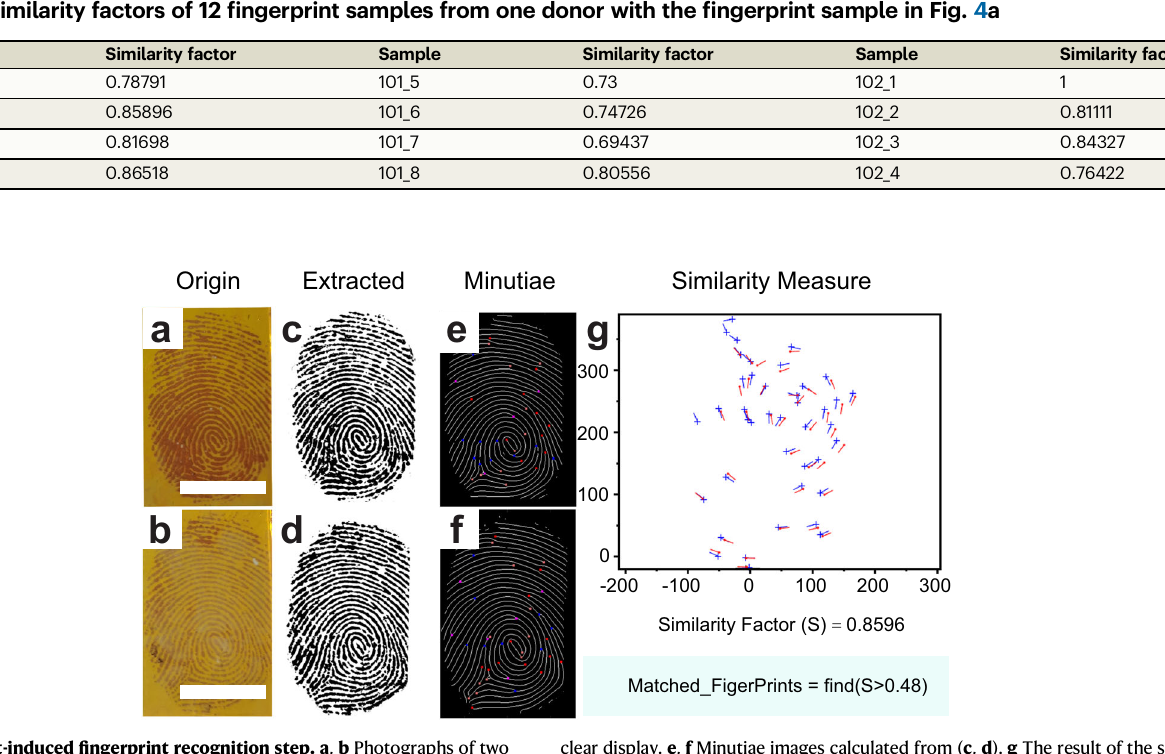
Fig. 4 | Sweat-induced fi ngerprint recognition step. a , b Photographs of two sweat-induced fi ngerprints. c , d Images extracted from ( a , b ), respectively. The black ( c , d ) colored images are added pseudocolors by a Photoshop program